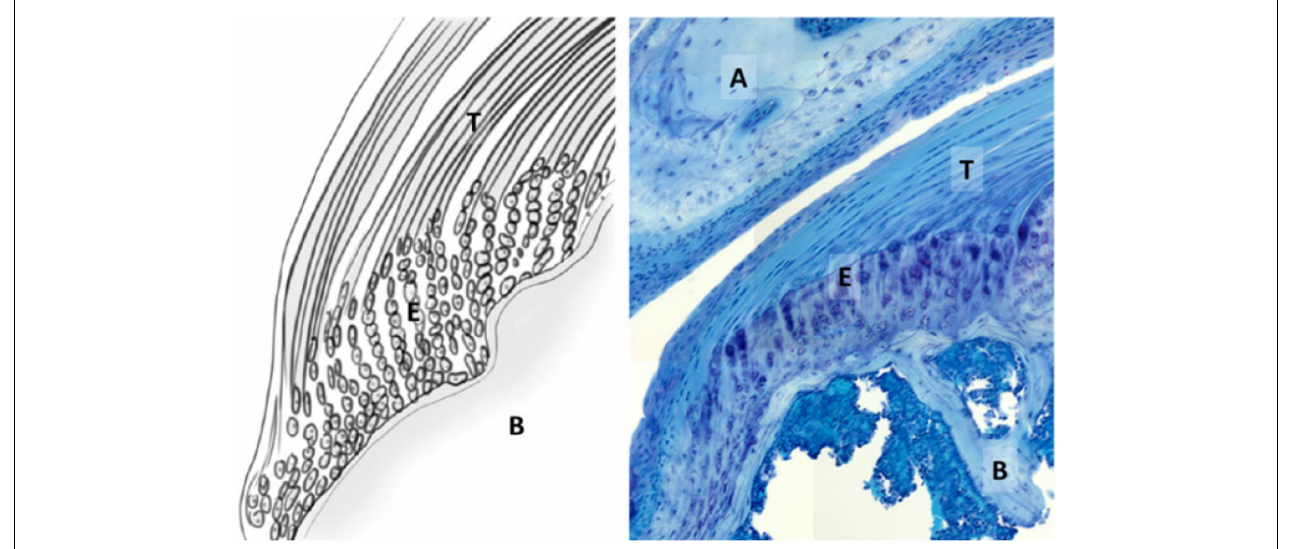
FIGURE 2 | Supraspinatus tendon-bone interface structure. T, supraspinatus tendon; E, enthesis; B, humeral bone; A, acromion (Bianco et al., 2019).